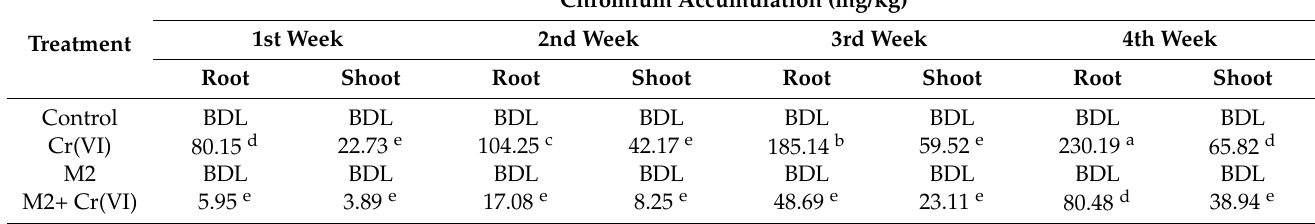
Table 5. Chromium concentrations in V. radiata tissues with and without inoculation of the rhizobac- terial strain